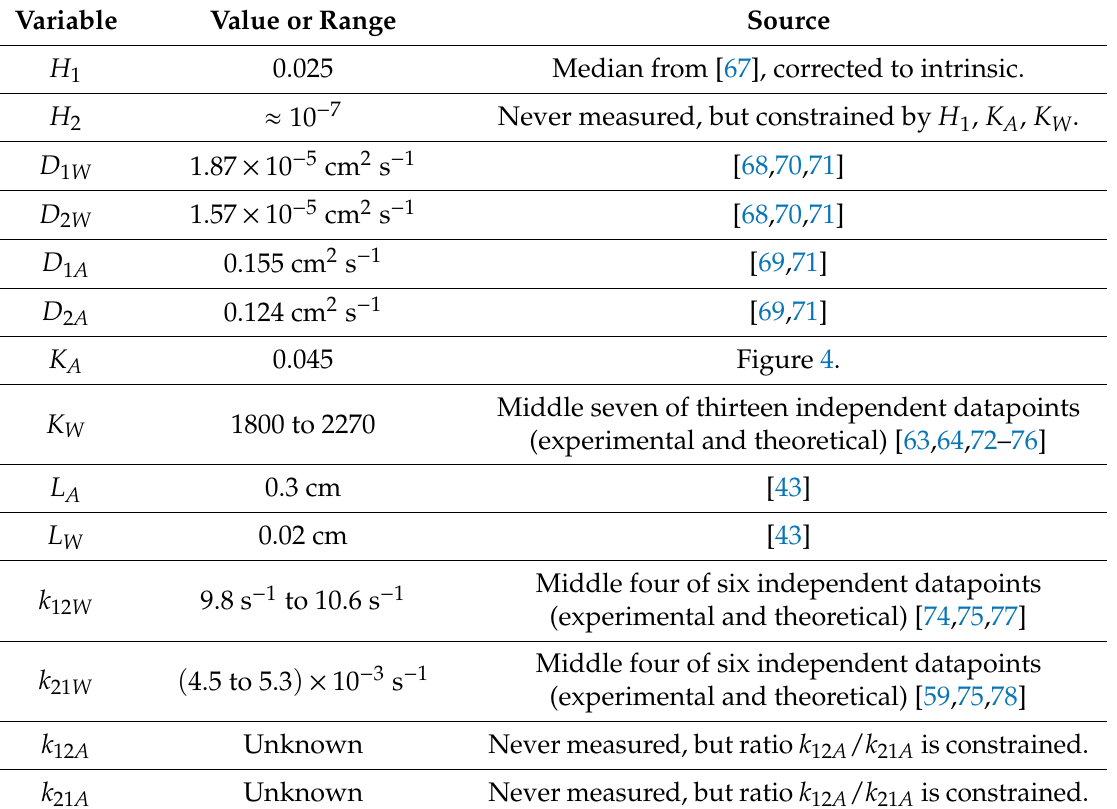
reaction at ≈ 300 K and pH 2